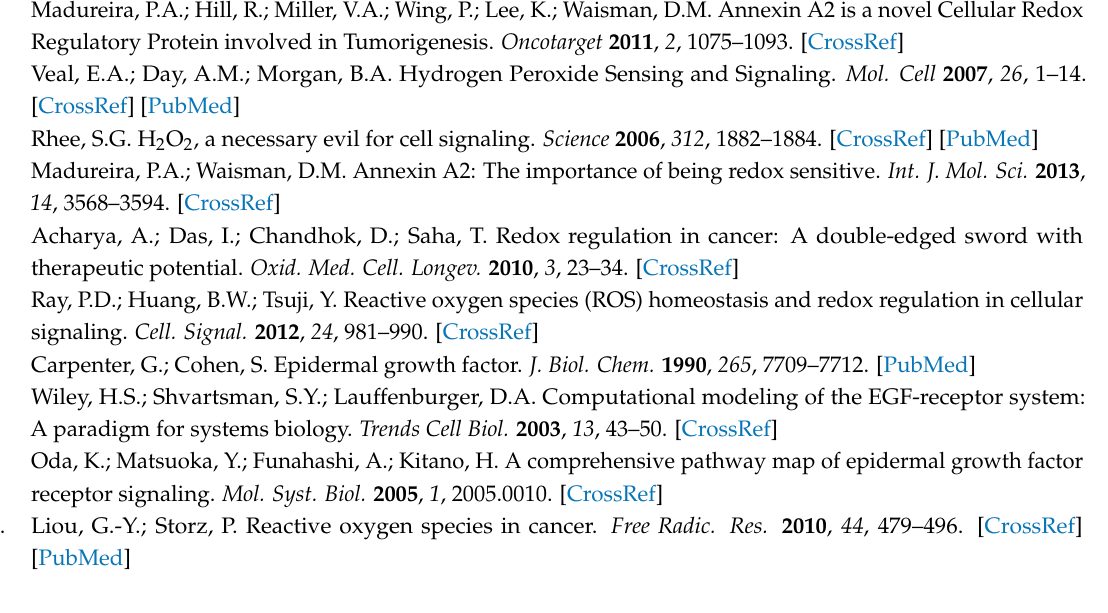
Figure S1: ANXA2 depleted cancer cells show enhanced AKT phosphorylation/activation upon EGF treatment compared to control cells, Figure S2: ANXA2 depleted cells show higher proliferation rate compared to matched control cells following EGF treatment, Figure S3: Analysis of ANXA2 shRNA cancer cell lines, Figure S4: Analysis of intracellular ROS levels in ANXA2 depleted versus control cells, Figure S5: Analysis of PRDX2 expression in ANXA2 KD cancer cells, Figure S6: HT1080 and MDA-MB-231 ANXA2 knockout cells show enhanced PRDX2 expression compared to control cells, Figure S7: PRDX2 depleted cancer cells show identical levels of ANXA2 expression compared to control cells, Figure S8: Immunofluorescence staining of ANXA2 and PRDX2 in colon clinical samples. Table S1: Analysis of ROS related genes in ANXA2 depleted versus control cancer cells, Table S2: List of shRNA and CRISPR/Cas9 plasmids, Table S3: Antibodies list, Table S4: qRT-PCR primers